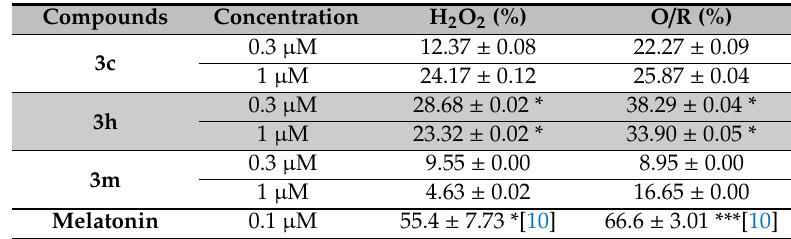
Table 2. Neuroprotective activity of compounds 3c , 3h and 3m on H 2 O 2 (200 µ M) or oligomycin O at 10 µ M) / rotenone (R at 30 µ M)-induced cell death in SH-SY5Y cells a